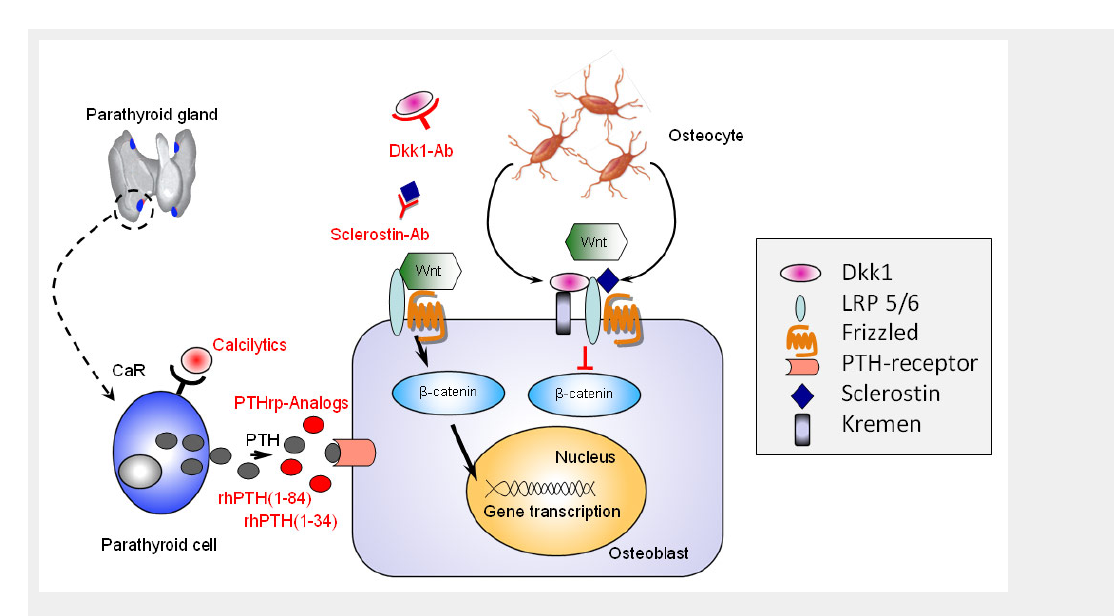
Targeting osteoblasts to stimulate bone formation. Recombinant human full length parathormone, rhPTH (1-84), its N-terminal segment rhPTH (1-34) and PTH related protein (PTHrp) analogues exert their bone anabolic after binding to the PTH receptor present on the osteoblasts. Calcilytics modulate PTH secretion by shifting the setpoint of the calcium-receptor (CaR) found on parathyroid cells. Sclerostin and Dickkopf-1 (dkk1) are endogenous inhibitors of the canonical